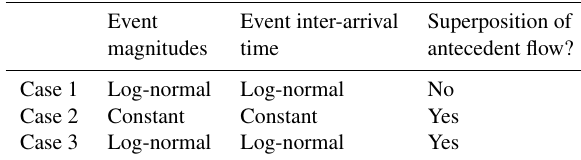
Table 1. Synthetic-hydrograph